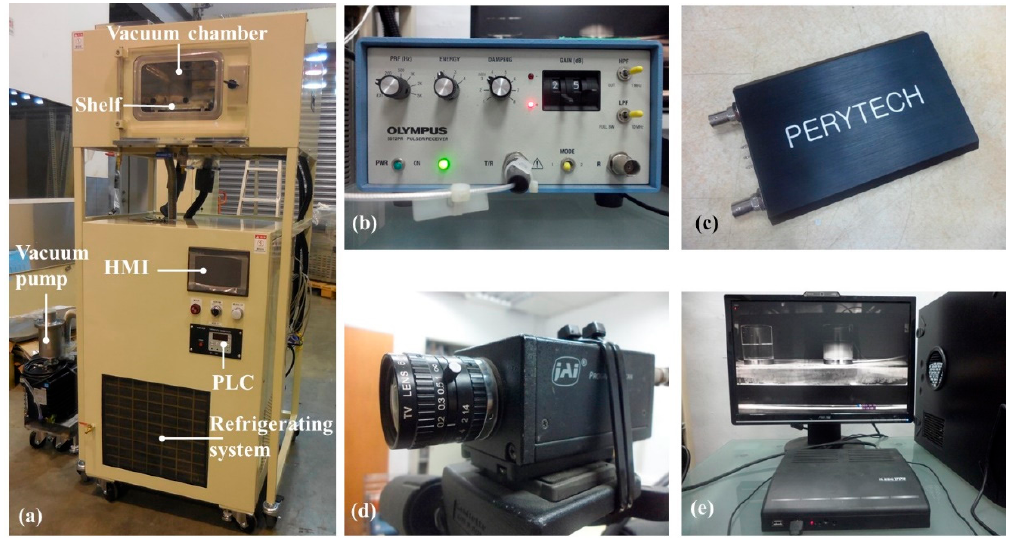
Figure 4. Photographs of ( a ) the split-type freeze-drying machine with vacuum chamber, controller unit, refrigeration unit and vacuum pump, ( b ) the ultrasonic pulse/receive unit, ( c ) a PC-based digital oscilloscope, ( d ) Charge-coupled device (CCD) camera, ( e ) digital video recorder (DVR) and PC.